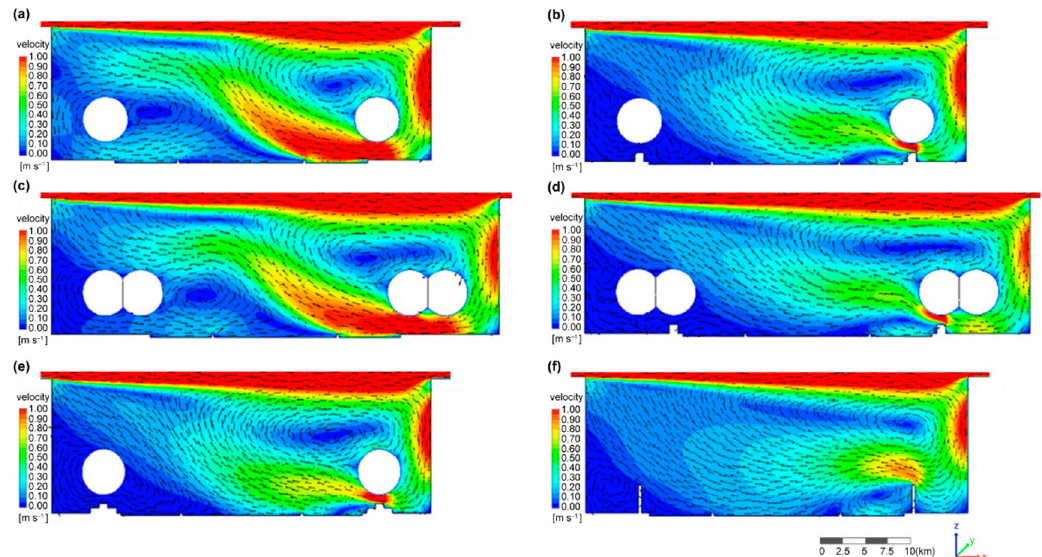
Figure 4. Velocity contours and in the eight-lane road, reproduced by numerical simulations with different vegetation configurations; scenario: ( a ) single-layer planting (E1), ( b ) multi-layer planting with a shrub height of 1 m (E2), ( c ) two-row single-layer planting (E3), ( d ) two-row multi-layer planting (E4), ( e ) multi-layer planting with a stepped shrub height (E5), and ( f ) vegetation barrier (E6).